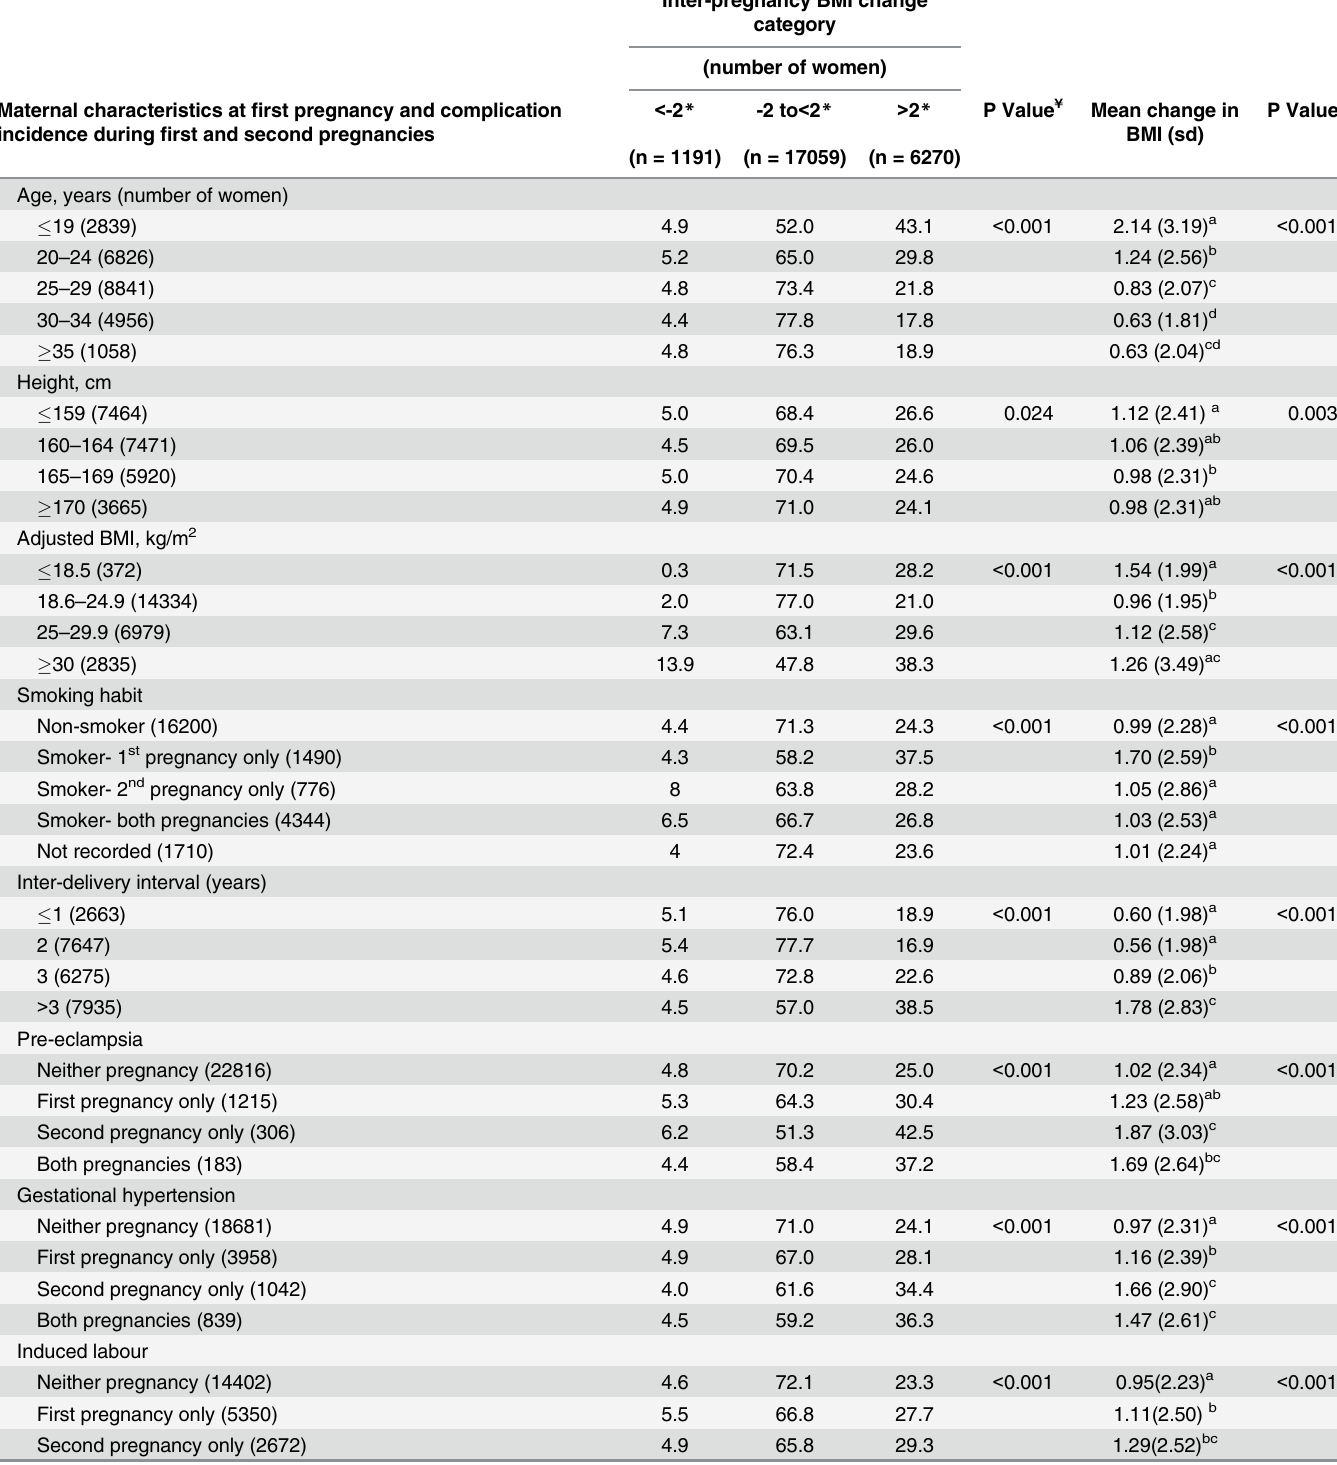
Table 1. Maternal characteristics and distribution of pregnancy complications in relation to inter-pregnancy BMI change category and mean change in BMI.